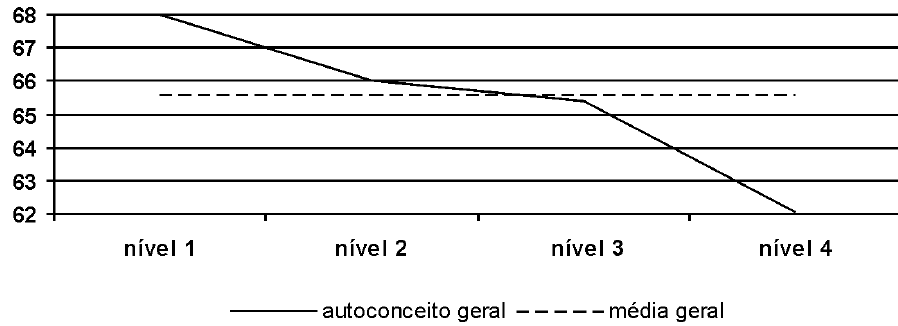
Figura 2 . MØdias do autoconceito geral por n(cid:237)veis de dificuldade de aprendizagem na